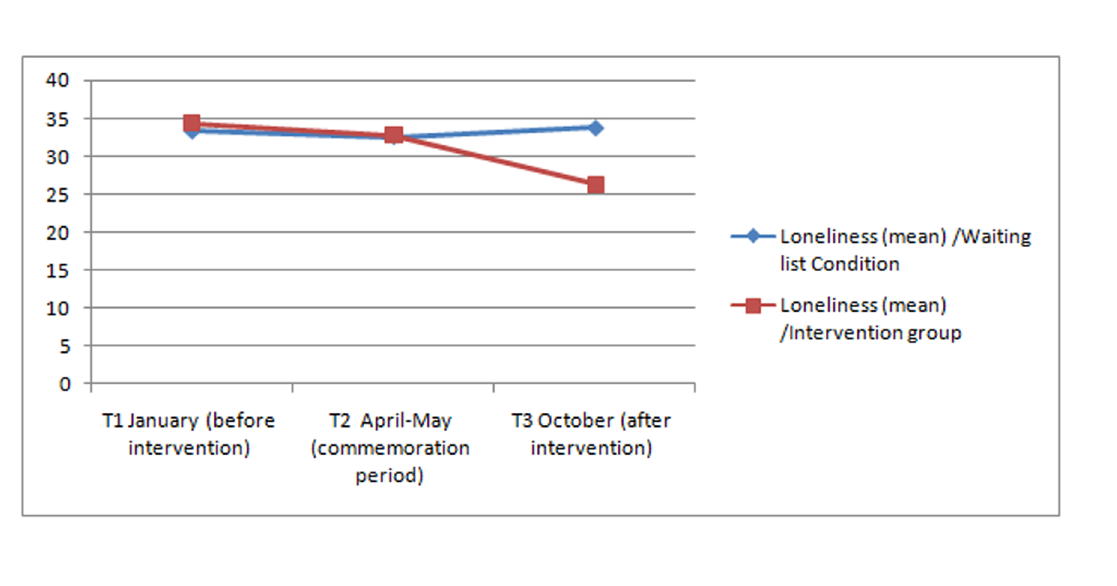
Figure 2. Evolution of the loneliness feeling across the course of the